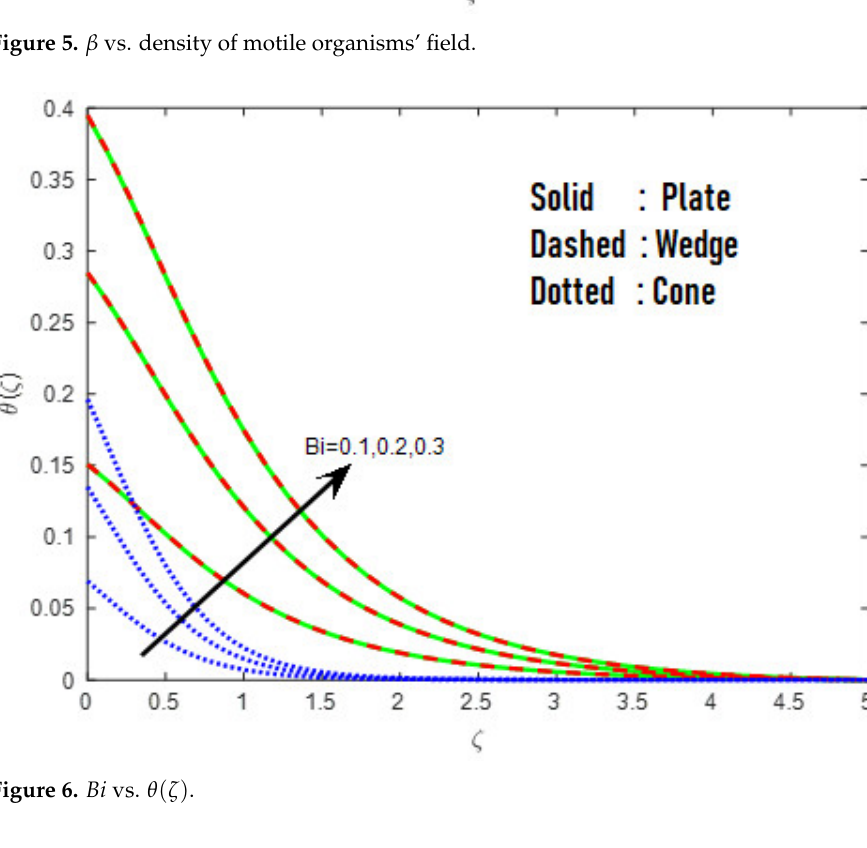
Figure 6. Bi vs. θ ( ζ ) Figure 6. Bi vs.     . Figure 6. Bi vs.     .